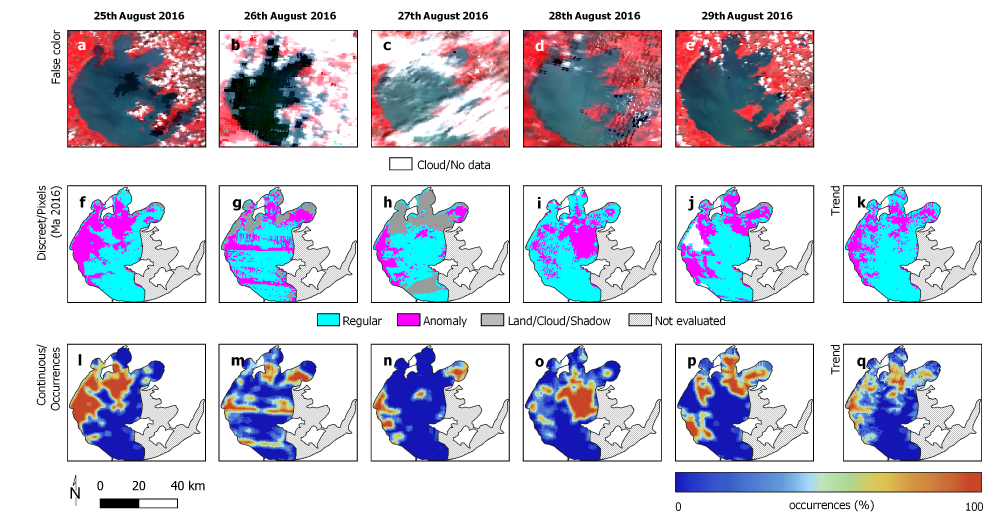
Figure 9. Images ( a – e ) in false-color composition (NIR, red and green bands) for the Lake Taihu study area from 25–29 August 2016. Regular, anomaly, land/cloud/shadow and undetermined samples ( f – j ) are identified by cyan, magenta, gray and black polygons, respectively; ( l – p ) show the local anomaly concentration at each instant; ( k , q ) represent the discrete and local anomaly concentration references for the whole forecasting